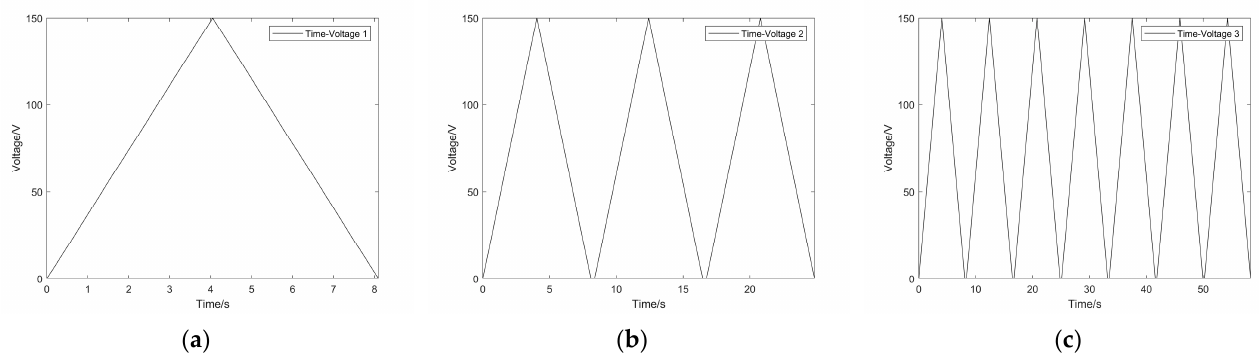
Figure 4. Experimental loading voltage: ( a ) first cycle voltage after start-up; ( b ) the first three cycles of voltage; ( c ) the first seven cycles of voltage.